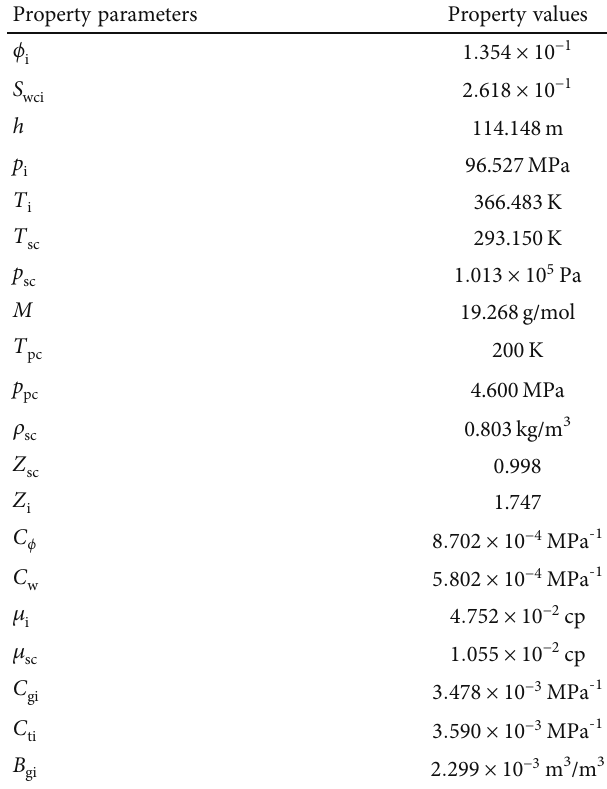
Þ to G for the gas well under variable BHP and variable production rate conditions. p ave Table 2: Reservoir and gas properties for the fi eld